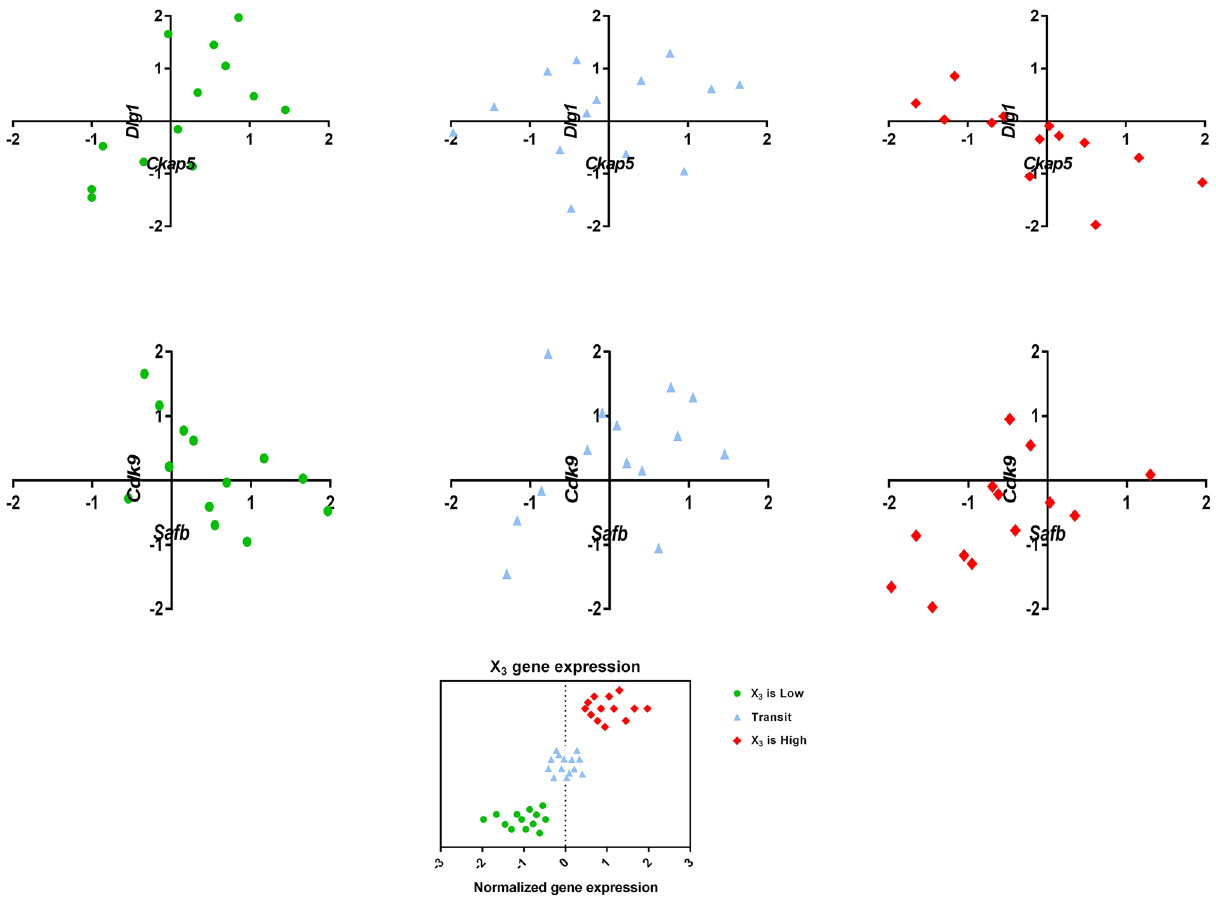
Figure 5. Scatter plot of two biologically relevant triplets. In each case, there is a considerable change in the correlation of X 1 and X 2 as a result of change in X 3 expression